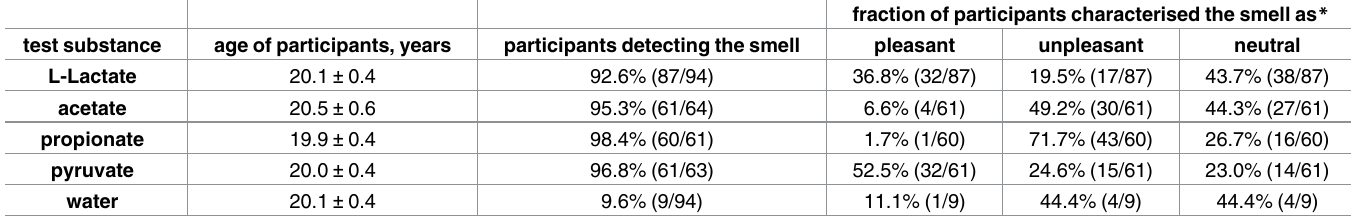
Table 1. Key outcomes of the human odour detection